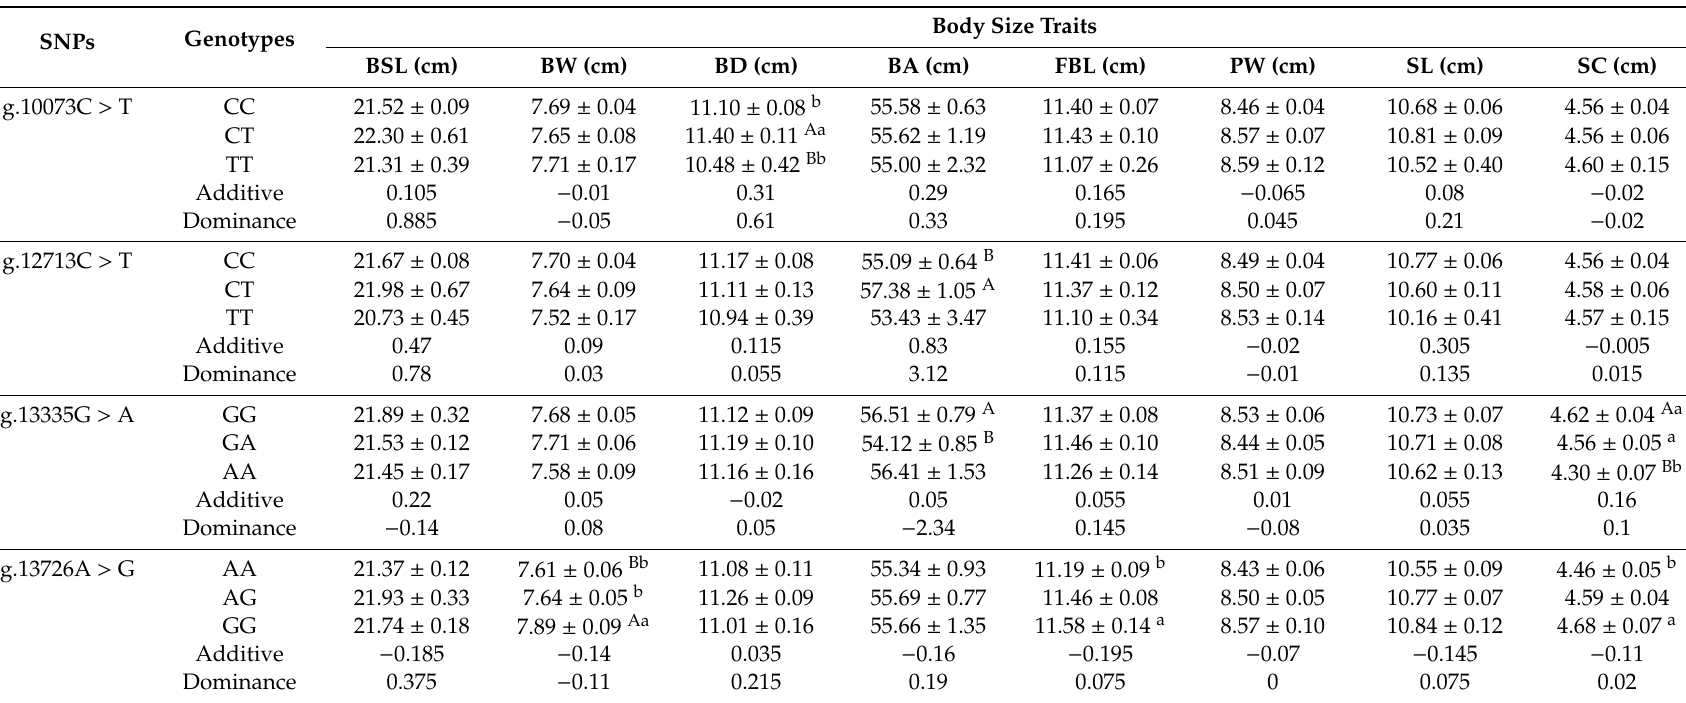
Table 5. Association of four SNPs of the PITX2 gene with body size traits in Wuliang Mountain Black-bone chickens ( MEAN ± SE